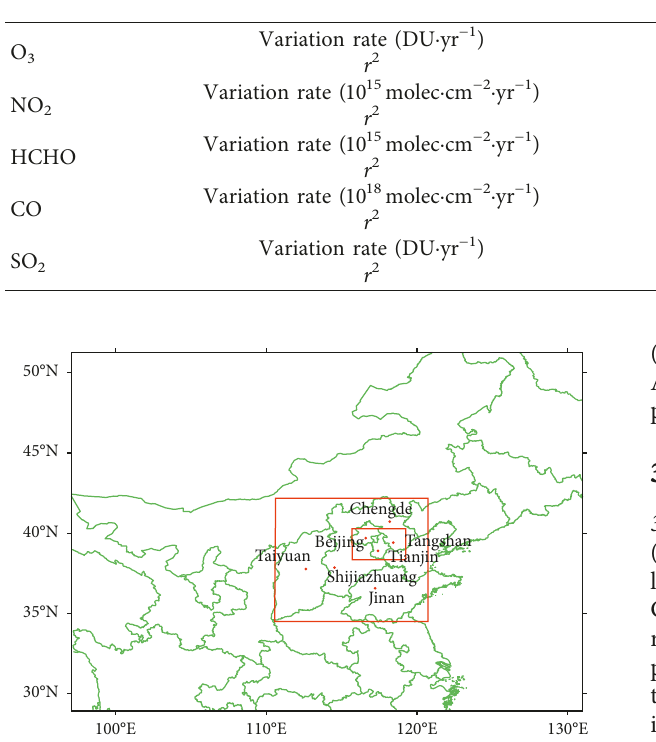
Figure 1: Location of the study area, NCP (outer rectangular area). The main cities considered are Beijing-Tianjin-Tangshan (BTT, inner rectangular area), Taiyuan (TY), Shijiazhuang (SJZ), Jinan (JN), and Chengde